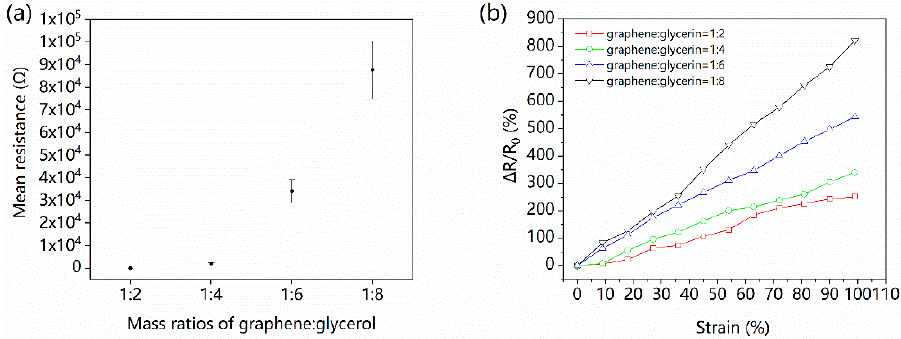
Figure 2. E ff ects of the graphene:glycerol ratio: ( a ) G / GL solution resistance for di ff erent mass ratios; ( b ) relative resistance changes plot of di ff erent mass Figure 2. Effects of the graphene:glycerol ratio: ( a ) G/GL solution resistance for different mass ratios; ( b ) relative resistance changes plot of different mass ratios.